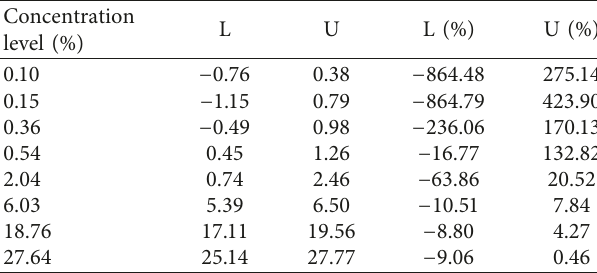
Table 6: The β -content, c -confidence tolerance intervals estimated for different concentration levels of tanshinoneII A